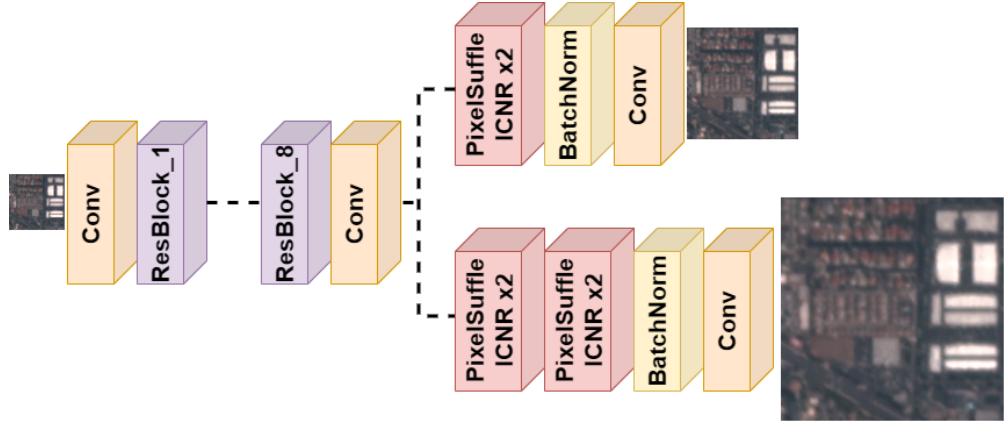
Figure 3. Architecture of